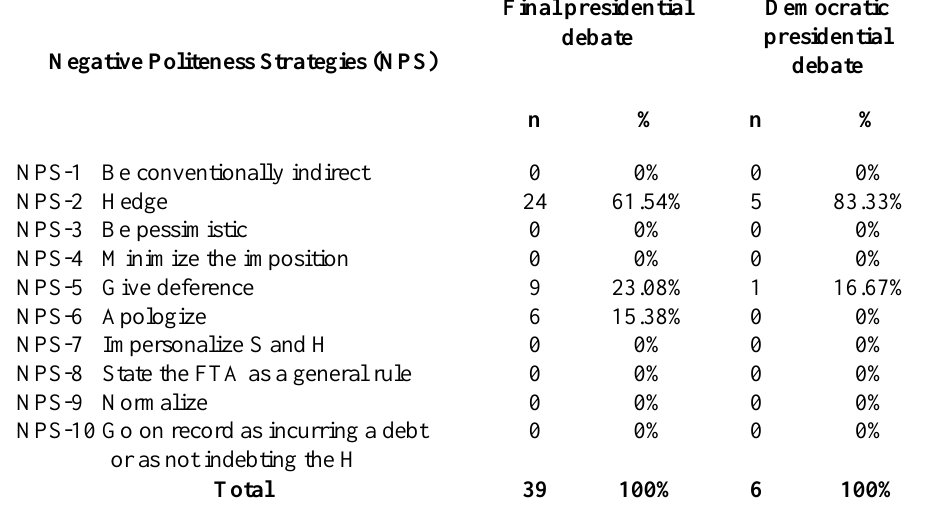
TABLE 4 | Distribution of negative politeness strategies in the two